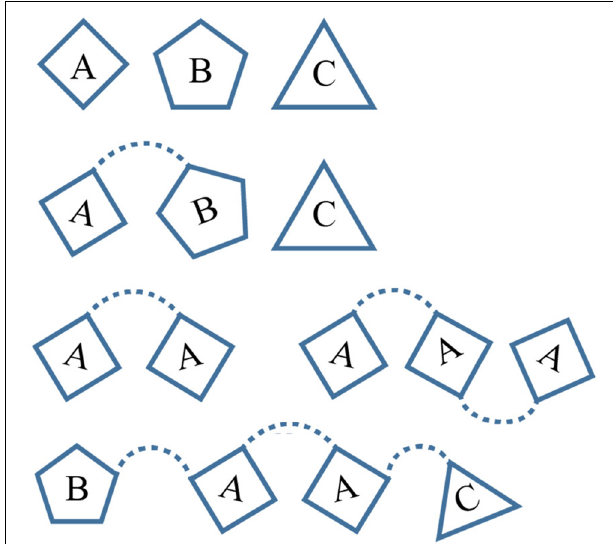
FIGURE 2 | A modular description of multi-domain proteins. The top row demonstrates three separate peptides of different structural domains, while a two-domain and a single domain protein are shown below. The final two rows demonstrate the difference between a “pure domain repeat” and a “combinatorial domain